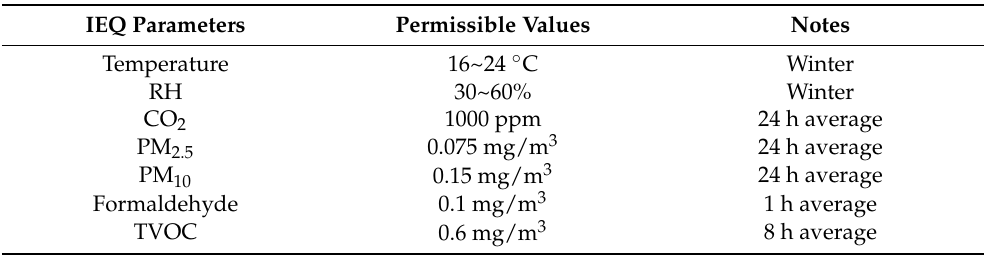
Table 2. Permissible values of thermal and IAQ parameters according to the Chinese national standard for indoor air quality [14].